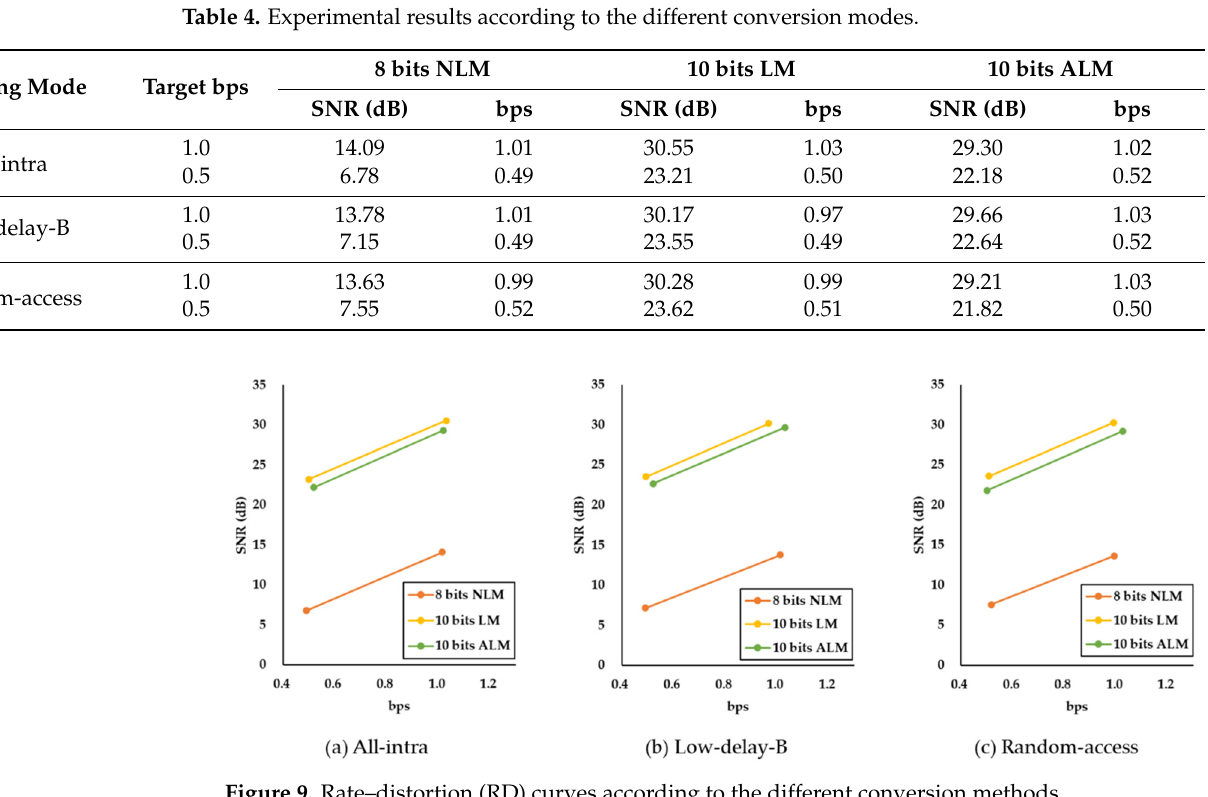
Figure 9. Rate–distortion (RD) curves according to the different conversion methods.